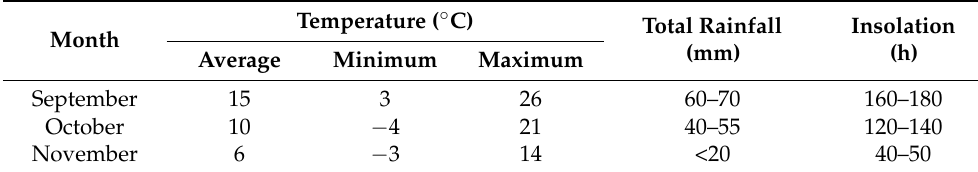
Table 4. Weather conditions during the storage of sugar beet